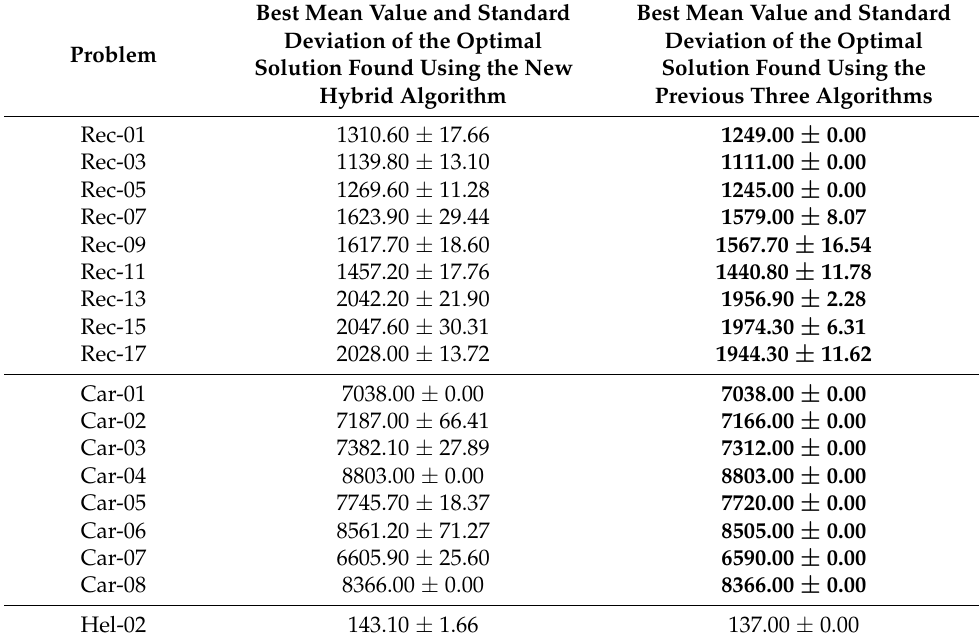
Table 7. Comparison of the mean value and standard deviation of the optimal solutions found using the new hybrid algorithm and from the previous three